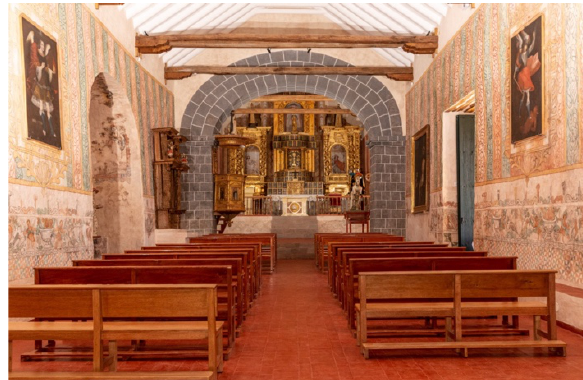
Figure 2 . Interior view of the church after its conservation.